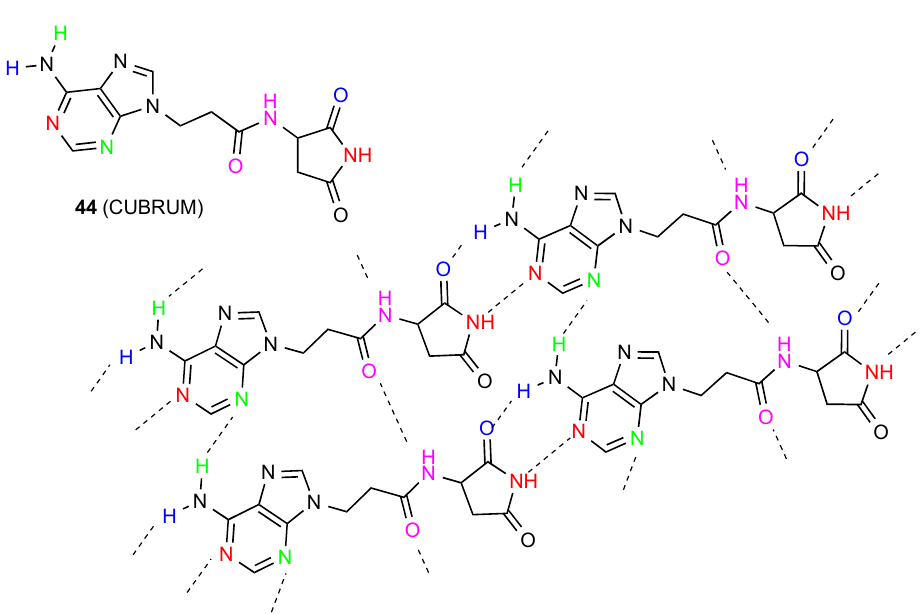
Figure 17. Structure observed for compound 44.